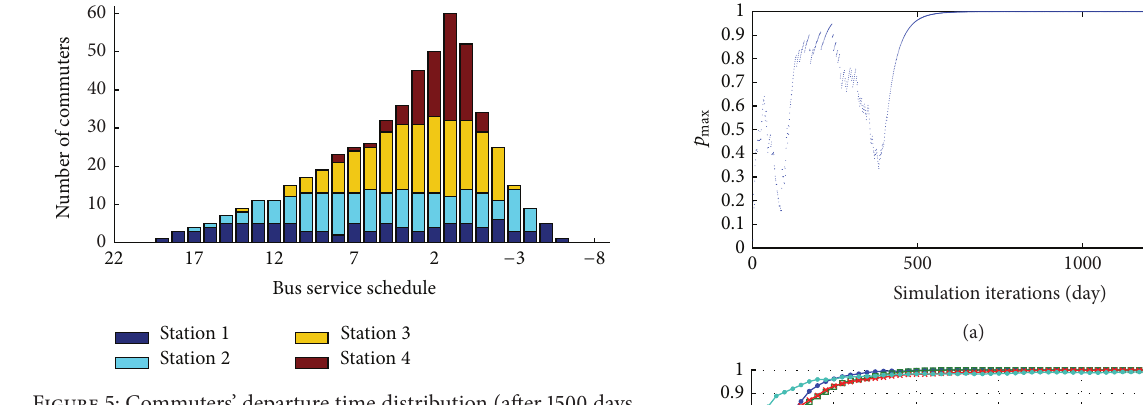
Figure 5: Commuters’ departure time distribution (after 1500 days evolution).